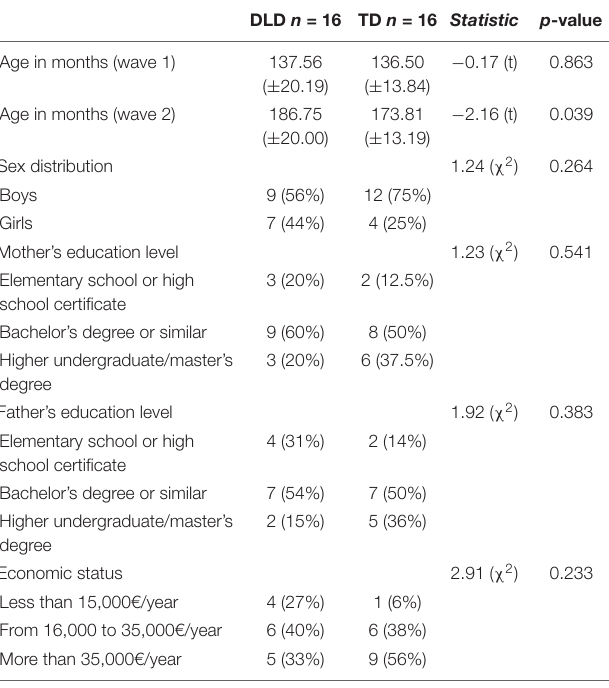
TABLE 6 | Standardized scores for language, cognitive assessment for adolescent with Developmental Language Disorder (DLD) and typically developing (TD) adolescent at wave 1 (Study